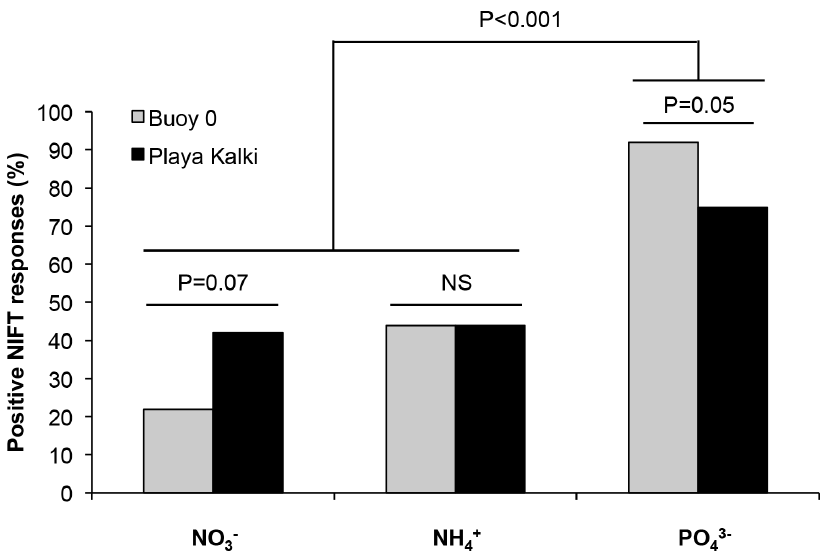
Figure 6. Nutrient limitation of Lobophoravariegata at two different research sites. Percentage of positive NIFT responses of L. variegata leaves, collected from Playa Kalki and Buoy 0, to addition of 100 m M of NO 3 2 , NH 4 + and PO 43 2 . Differences between the two research sites were tested with the Two Proportion Z-test. NS is not significant at P $ 0.10; n=36 per research site and nutrient treatment.